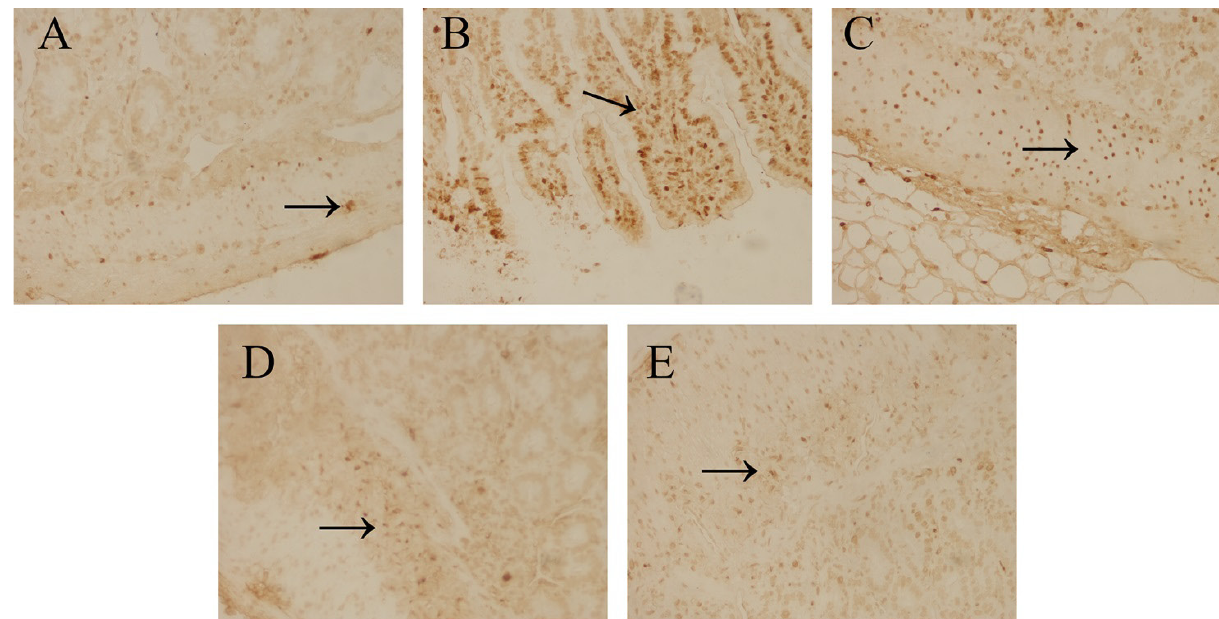
Fig. 4. The pathological sections of intestinal tissue and TUNEL staining in the sham group (6A), in the CLP group (B), in the CTX group (C), in the imipenem+NS group (D) and in the imipenem+NS+CTX group (E). The arrows indicate the apoptosis